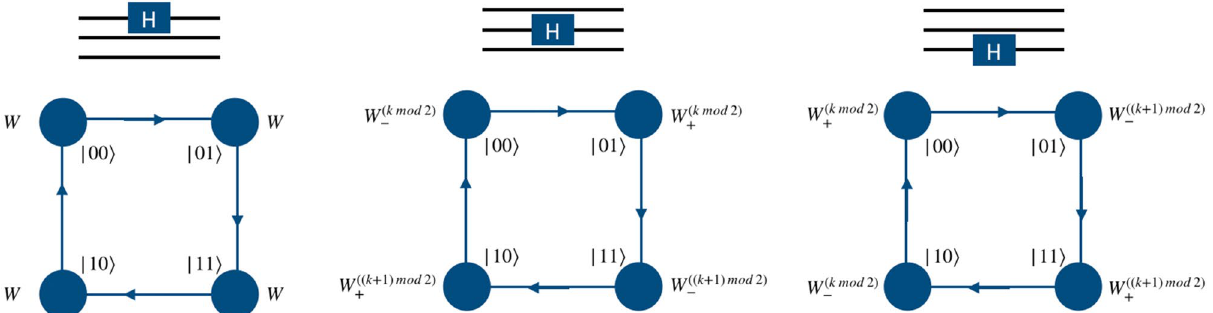
Figure 5. Schematic illustration of the Hadamard operation on the computational basis of the three-qubit system using position dependent quantum walk operators. The form W of the operators involved in realization of Hadamard operation on second and third qubit are in Eq.